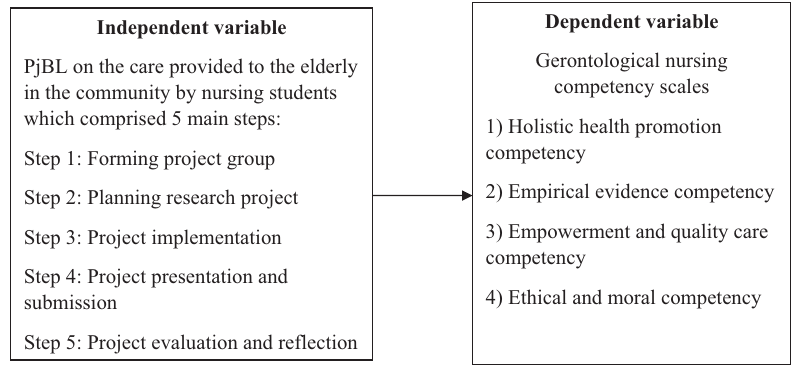
Figure 1. Theoretical